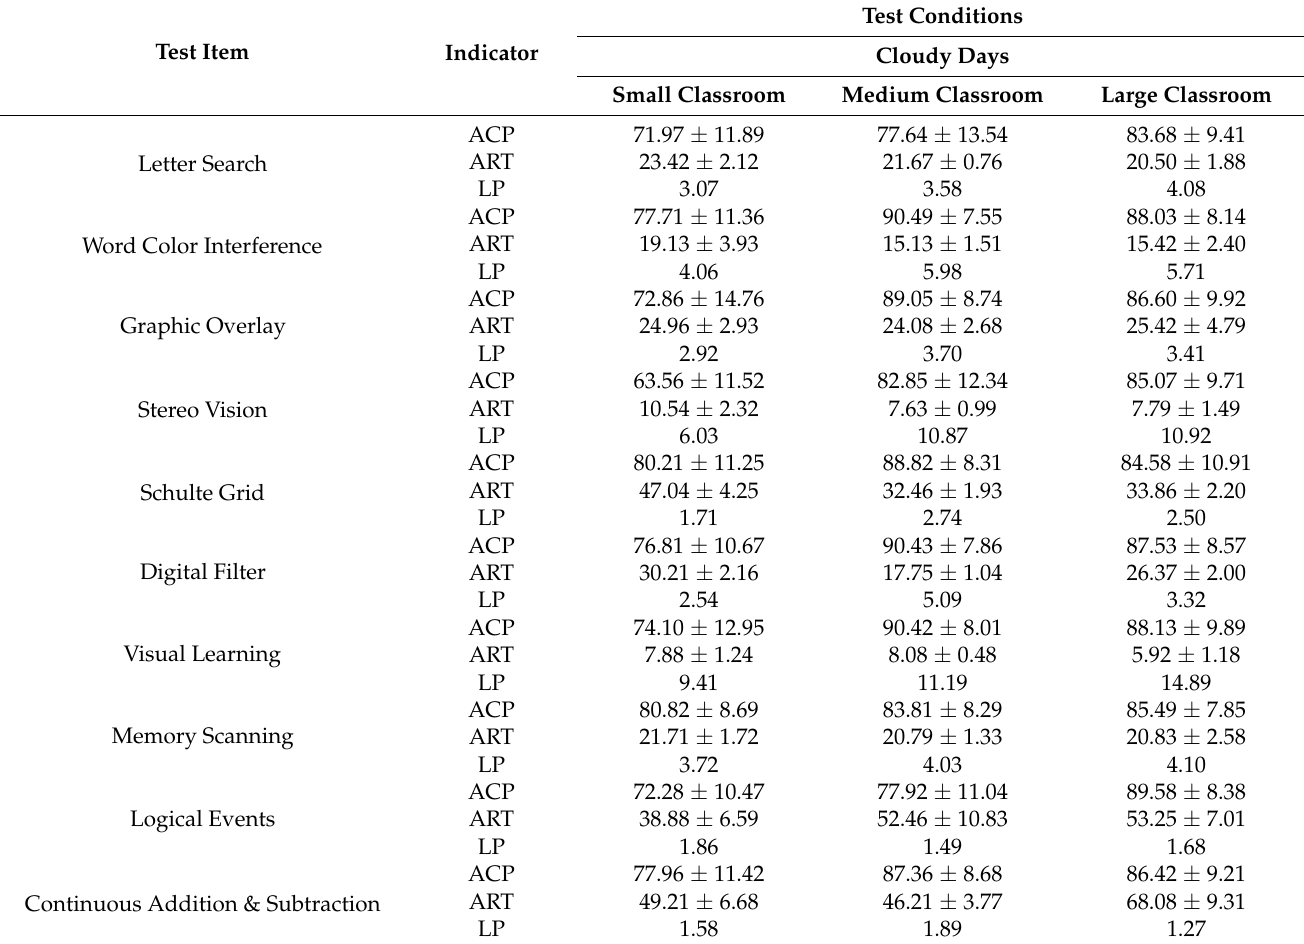
Table A4. The final results of the ACP, ART and LP of the relevant test items on cloudy days.